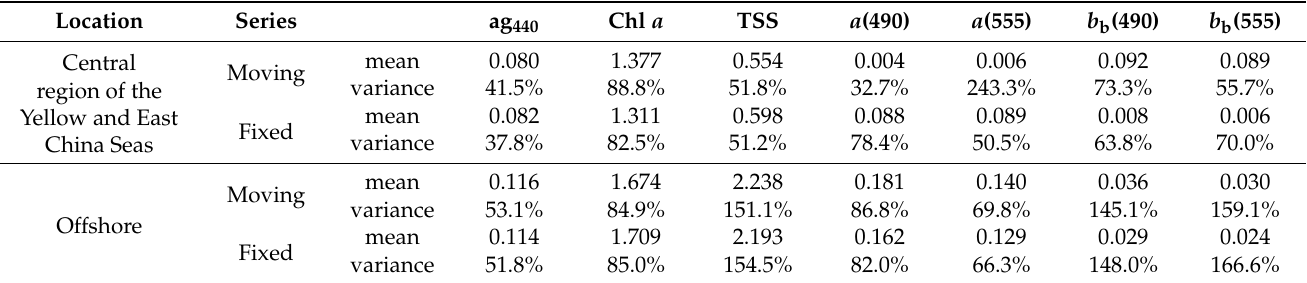
Table 7. Regional differences of